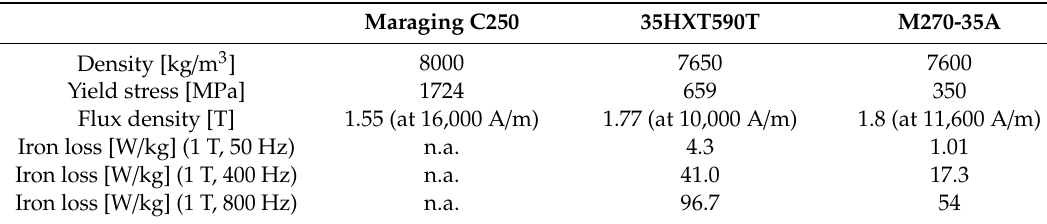
Table 2. Rotor materials’ physical